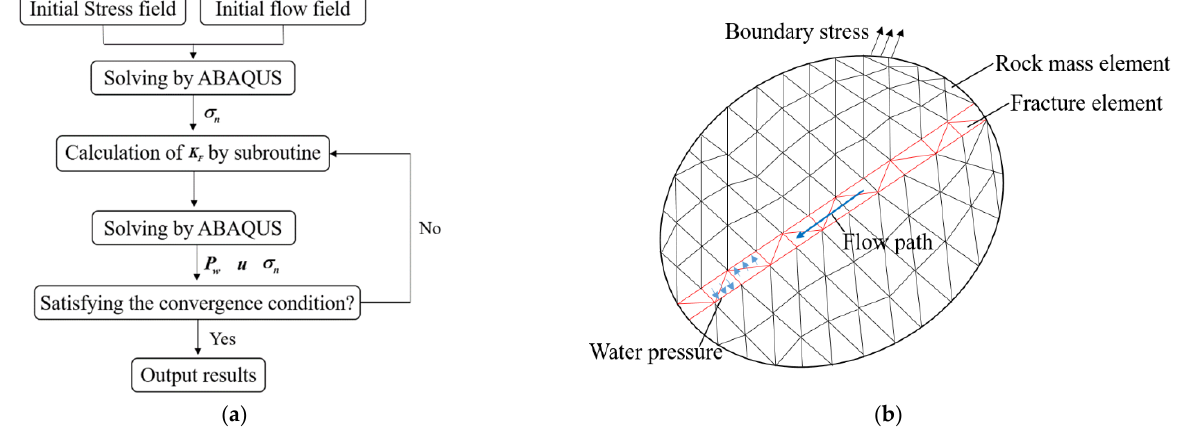
Figure 8. ( a ) Coupled process of the model; ( b ) geometric model.